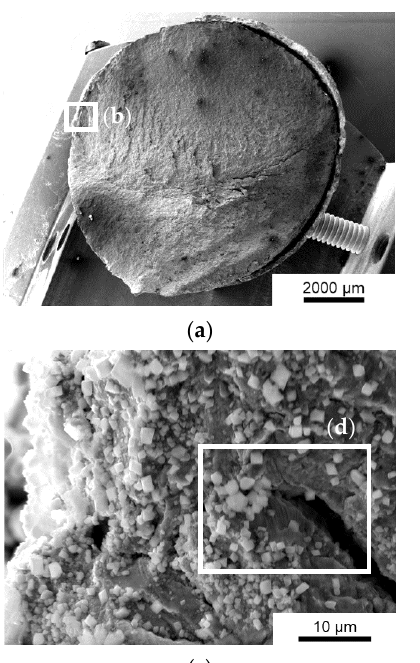
Figure 13. Macrographs of specimens after corrosion fatigue testing, ( a , b ) sandblasted (I) loaded at 320 MPa, ( c , d ) MHP post-treated (III) loaded at 320 MPa, ( e ) machine hammer-peened (III) loaded at 280 MPa.